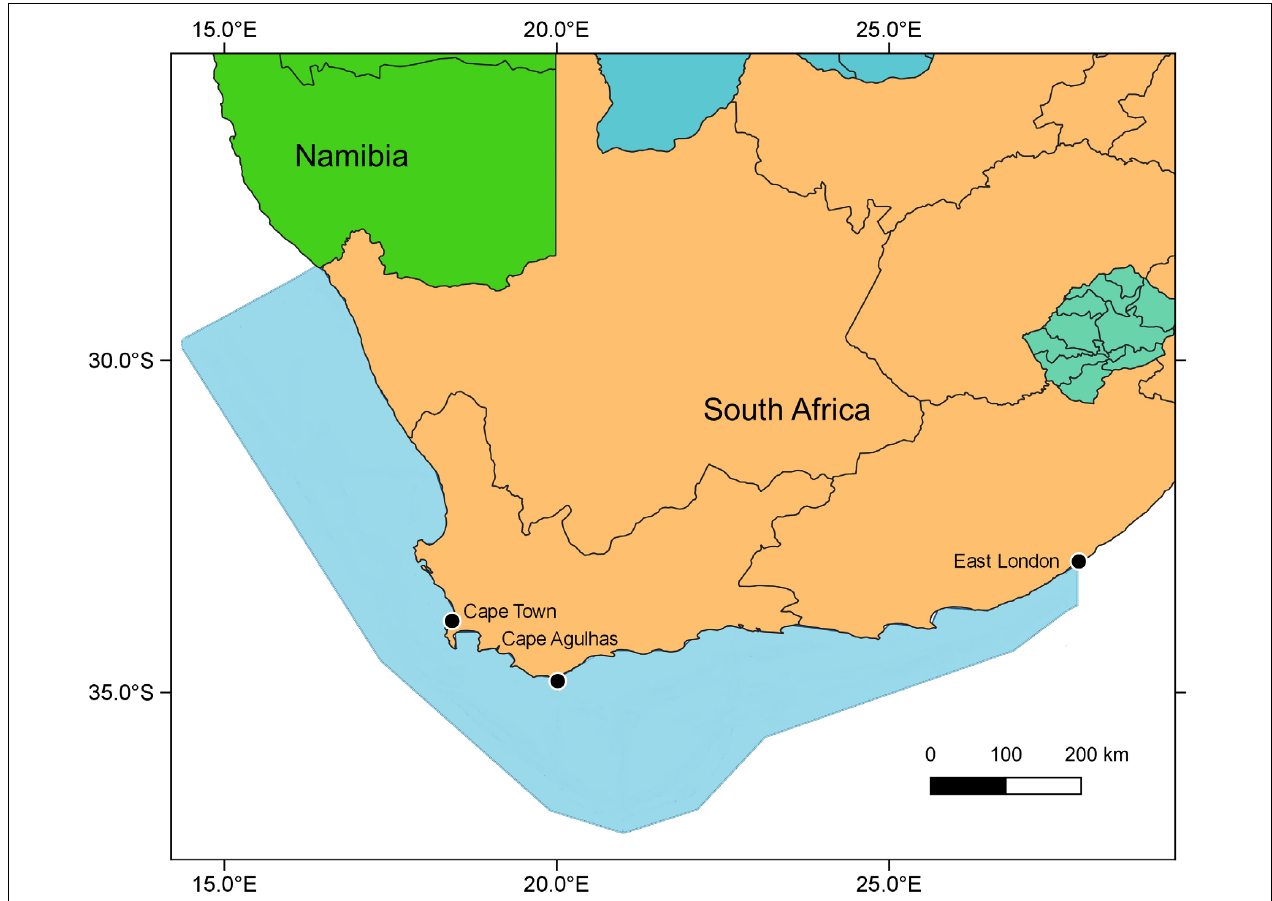
FIGURE 1 | Map showing modeled area (blue shaded) and Cape Agulhas, determining the boundary between the west coast vs. the south coast subsystems of the Southern Benguela ecosystem (Hutchings et al., 2009; Watermeyer et al.,